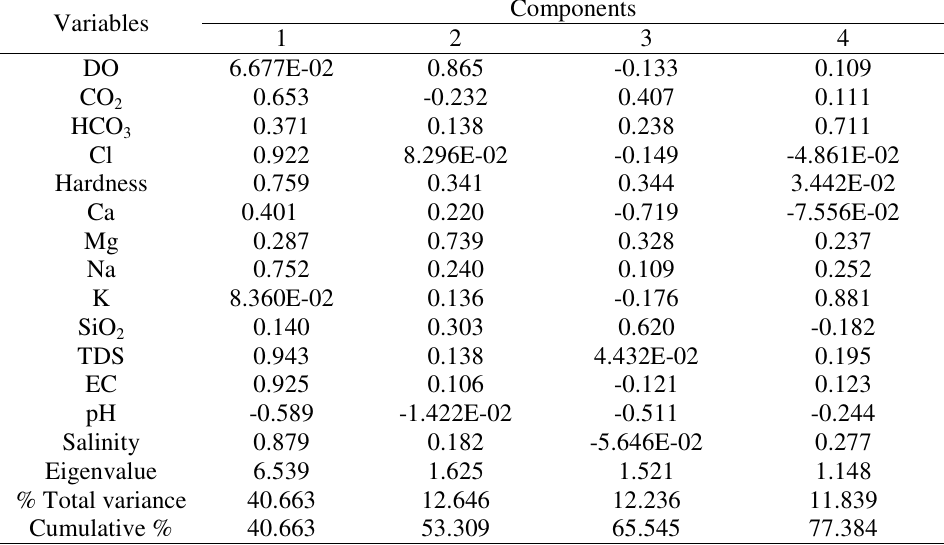
Table 4. Rotated component matrix, eigen value, percentage of total variance and cumulative percentage of